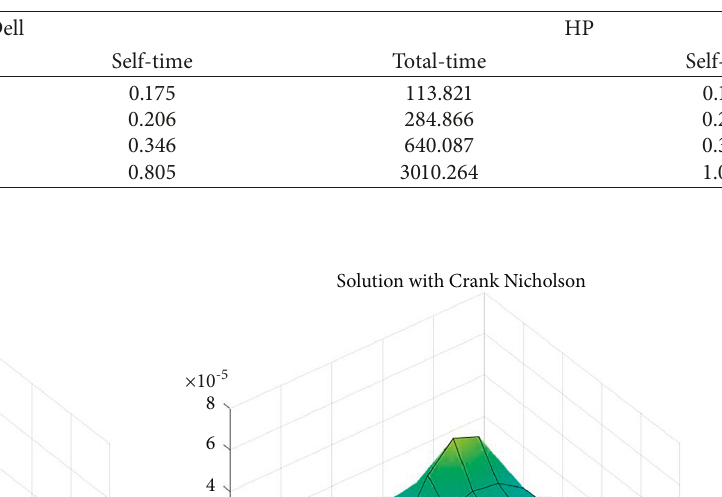
Table 7: Performance of CPU time efficiency using FVM.